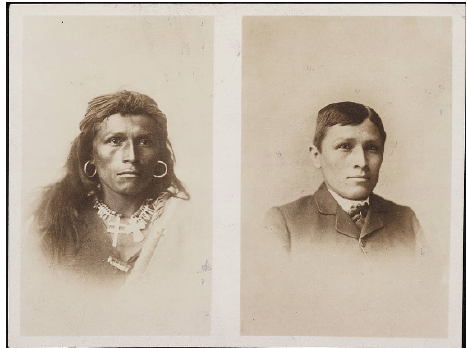
Figure 1. the image of Tom Torlino. Figure 1. The image of Tom